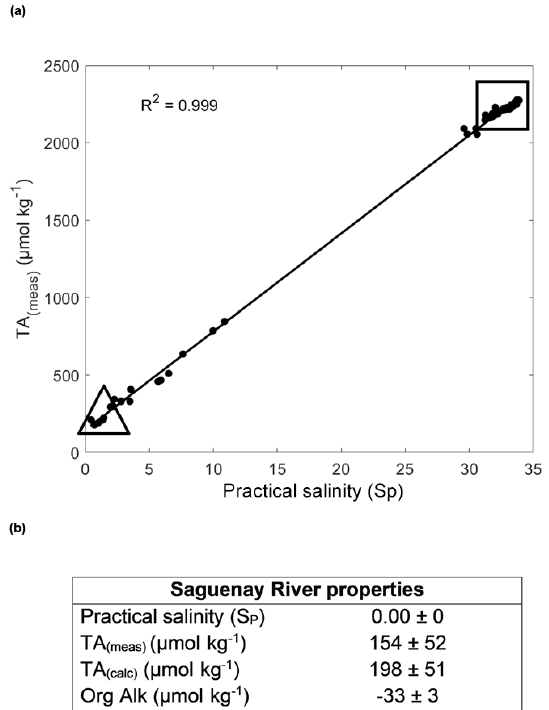
Figure 2. (a) Measured alkalinity (TA ( meas ) ) vs. practical salinity ( S P ) for SRW and CIL data points for all sampling months ( R 2 = 0 . 999). The triangle defines the properties of the SRW, and the square comprises the properties of the CIL. (b) TA ( meas ) , TA ( calc ) and Org Alk definitions for the Saguenay River (SRW), using sur- face water data from all sampling months, with standard error. The Org Alk (positive) contribution to the TA of the CIL is not consid- ered, as it accounts for less than 0.1% of its